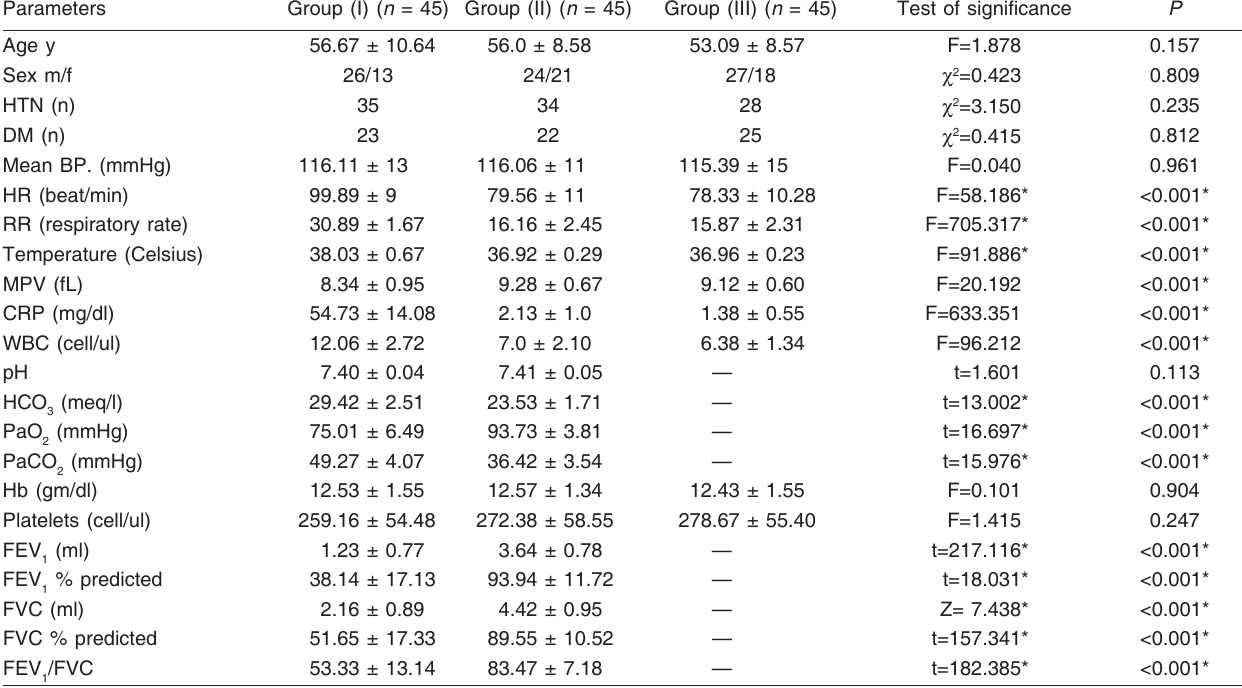
Table 1: Demographics, functional parameters, and laboratory results of patients of exacerbations of COPD, smokers and controls Parameters